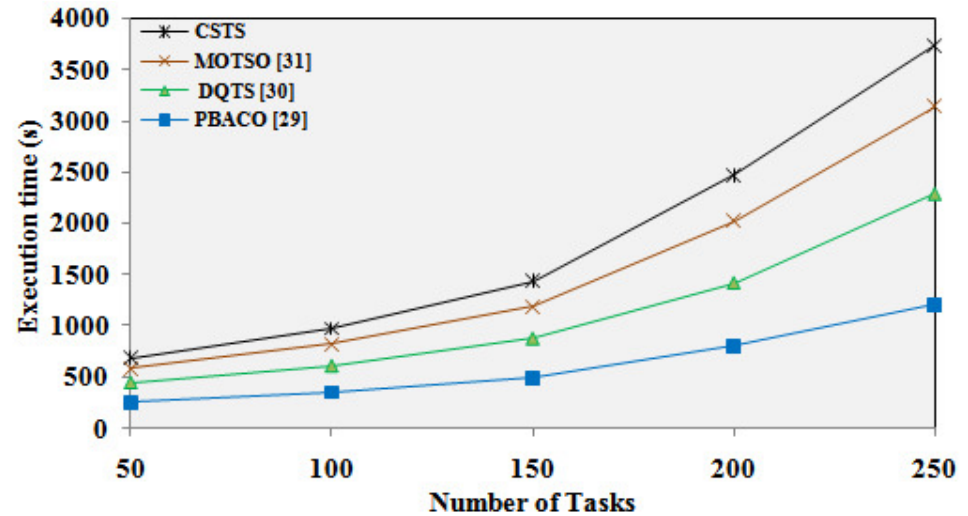
standard respectively. The average resource utilization of proposed CSTS method is 10.99% and 8.236% much thrived than the existing task scheduling models for number of tasks and task standard